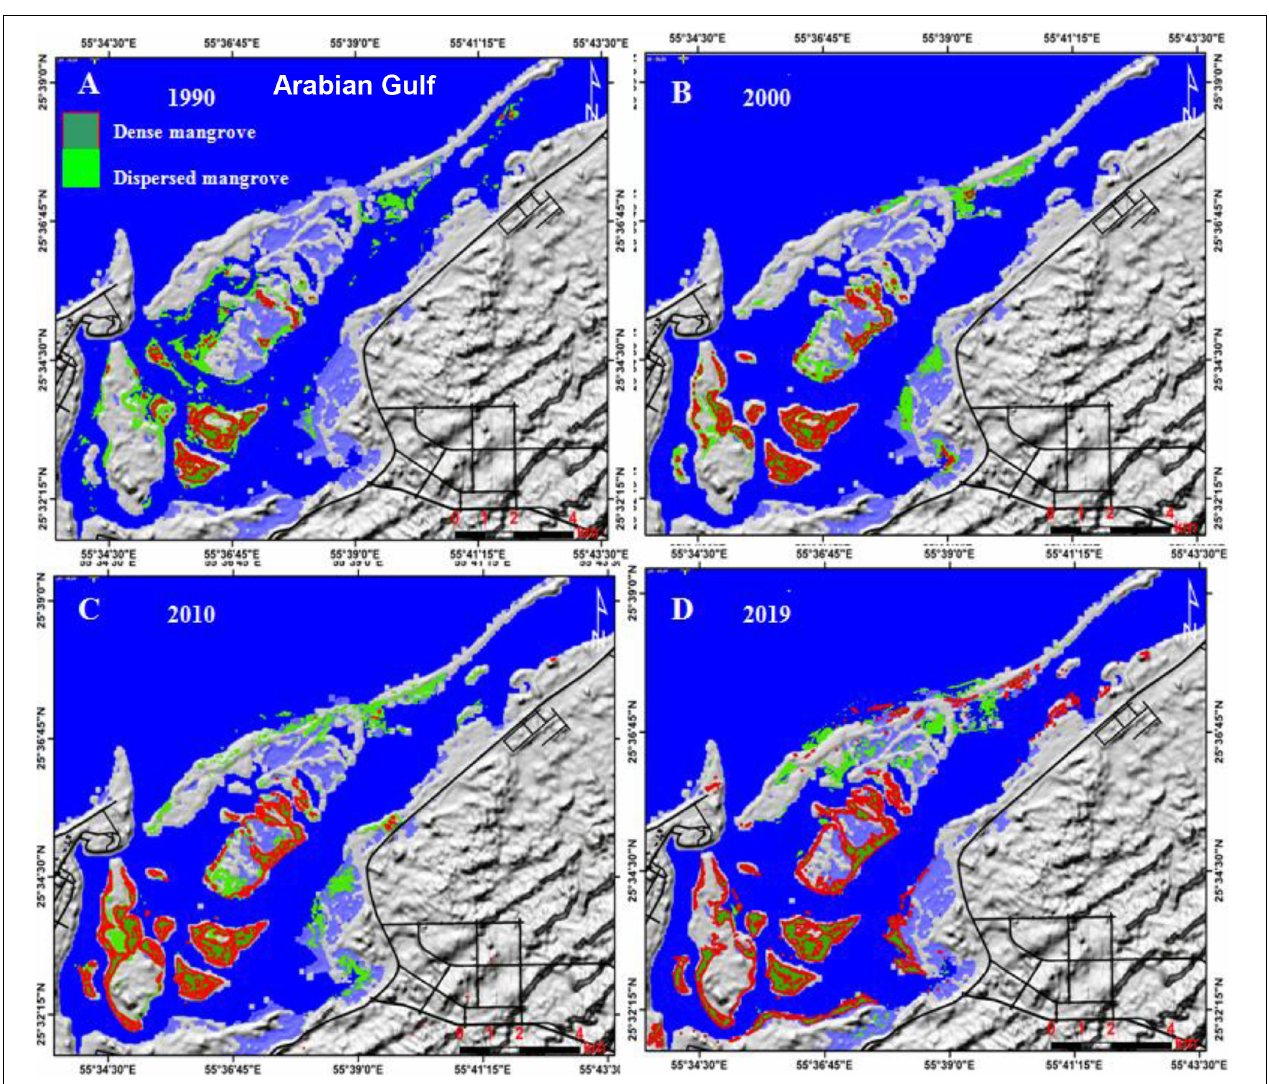
FIGURE 10 | Spatiotemporal variations of mangrove forests in Umm Al Quwain natural reserve for the years 1990 (A) , 2000 (B) , 2010 (C) , and 2019 (D) . Red polygons highlight dense